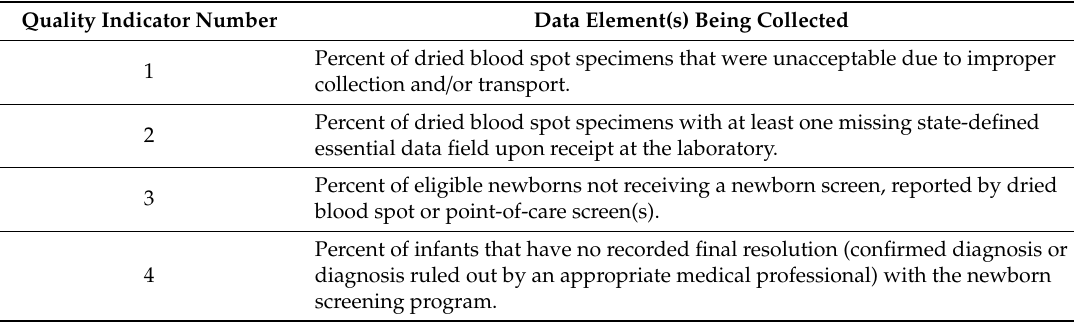
Table 4. National Newborn Screening Quality Indicators (Final as of 2016).